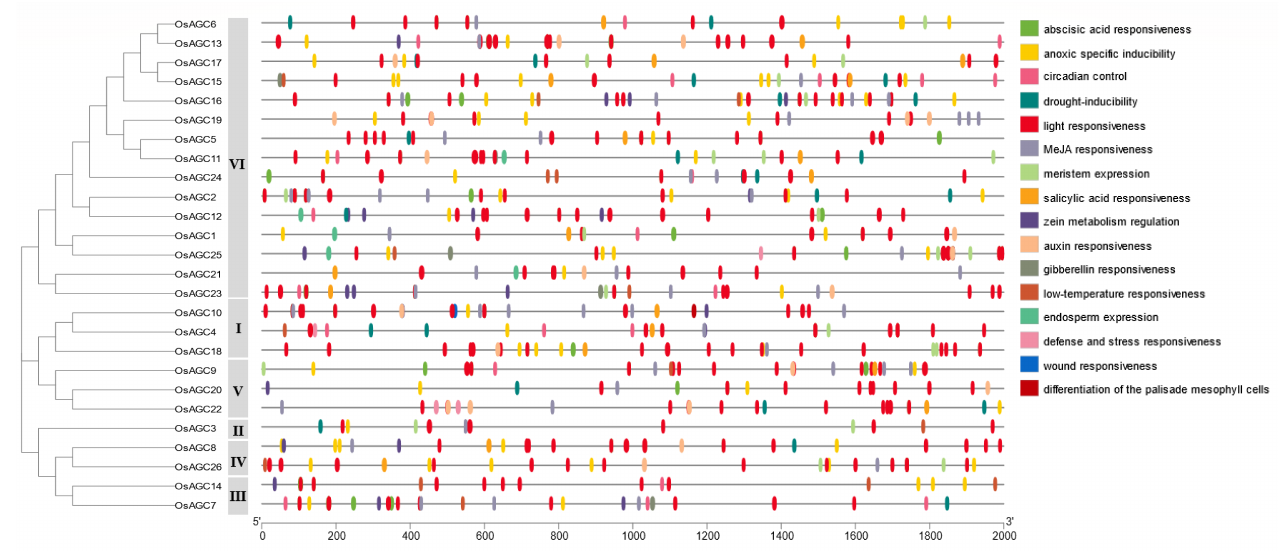
Figure 5. Predicted cis-elements of the OsAGC gene